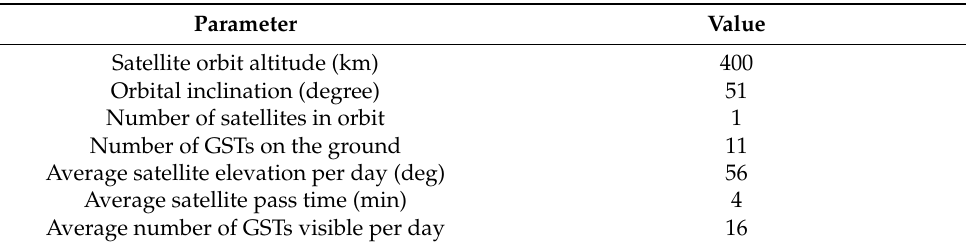
Table 7. Parameters for estimation of average SIoT capacity.